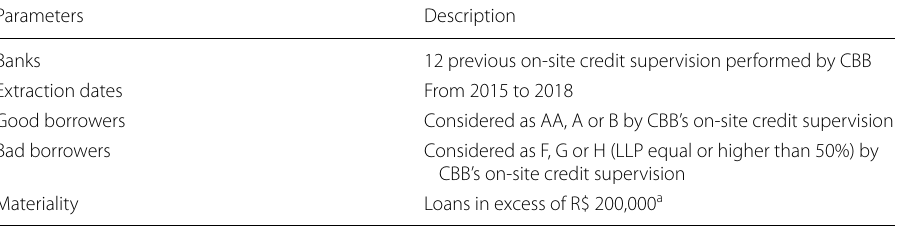
Table 3 Parameters and criteria adopted to classify borrowers according to CBB on-site credit